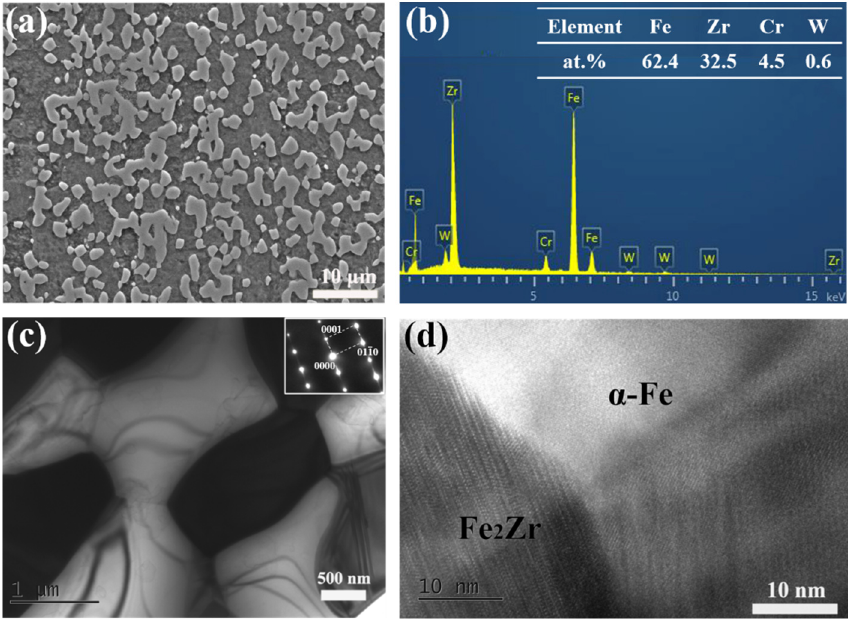
Figure 2. ( a , b ) SEM/EDS, ( c ) TEM, and ( d ) HRTEM image of the Fe-Cr-Zr alloy. ( b ) EDS point analysis of Fe 2 Zr phase. The inset in ( c ) represents the SAED patterns of Fe 2 Zr phase.